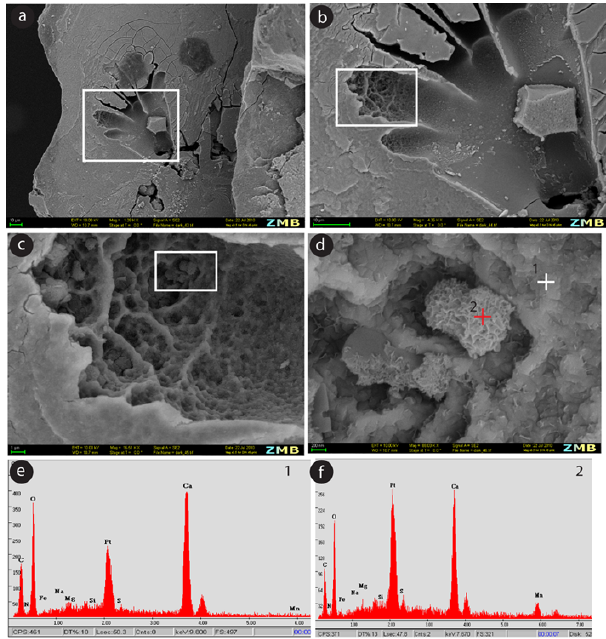
Fig. 14. Secondary electron images of the ferromanganese crusts covering microborings in calcite: (a) microborings made of tunnels; (b, c) part of tunnels covered by an alveolar network; (d) particule displaying a crenulated surface structure; (e) elemental analysis of the alveolar network mainly composed of low-magnesium calcite; (f) elemental analysis of the manganese oxide particle.